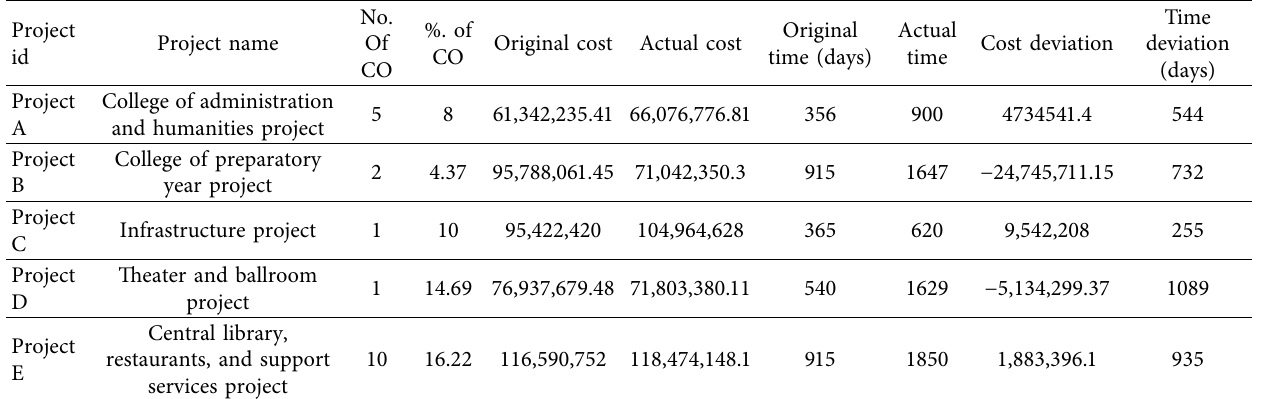
Table 2: Summary of the studied projects.